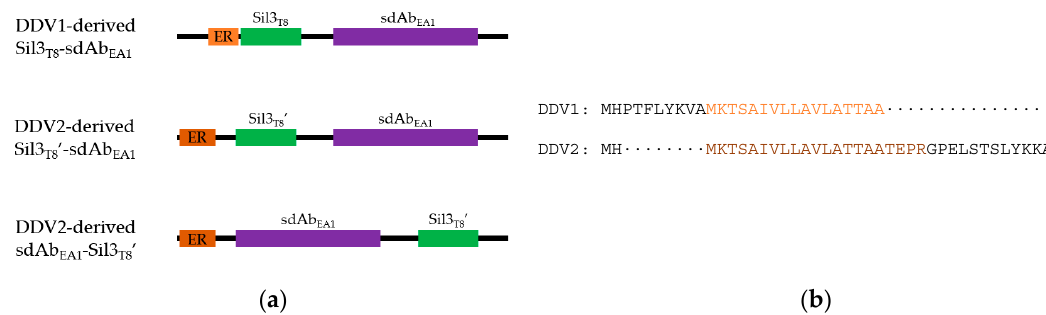
Figure 1. Diagrams of fusion proteins produced for this study. ( a ) Order of peptides in fusion proteins. Black lines—residual cloning scars; orange—ER trafficking sequence (light orange, 17 amino acids; dark orange, 21 amino acids); green—Sil3 T8 biosilica-targeting peptide (Sil3 T8 , original composite peptide with ER trafficking sequence and silica targeting peptide; Sil3 T8 ′ , uncoupled silica-targeting peptide); purple—sdAb EA1 (can be either clone A1 or G10, exact identity is not specified here). Diagrams are for illustration purposes, and are not drawn to scale. ( b ) Alignment of ER trafficking sequences in each diatom expression vector. The sequence shown is from the N-terminus of the fusion protein through the second peptide feature of the protein. Colors are the same as in ( a ).